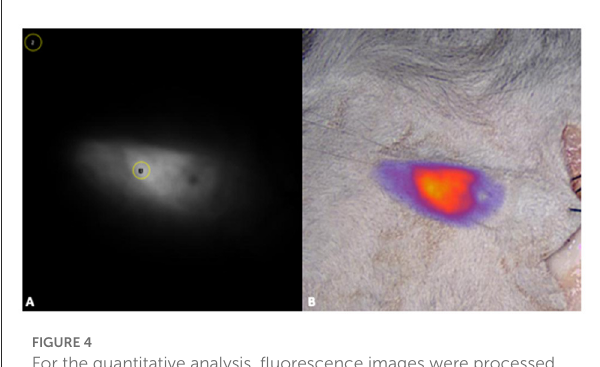
FIGURE4 For the quantitative analysis, fluorescence images were processed with a commercially available software (ImageJ), by drawing regions-of-interest (ROI) of 30 pixels in diameter were on the most fluorescent area (1) and on a non-fluorescent area on the uppermost left corner of each image (2) (A) . For the semi-quantitative evaluation overlay images produced with Visionsense TM V3 iridium were also used (B) .